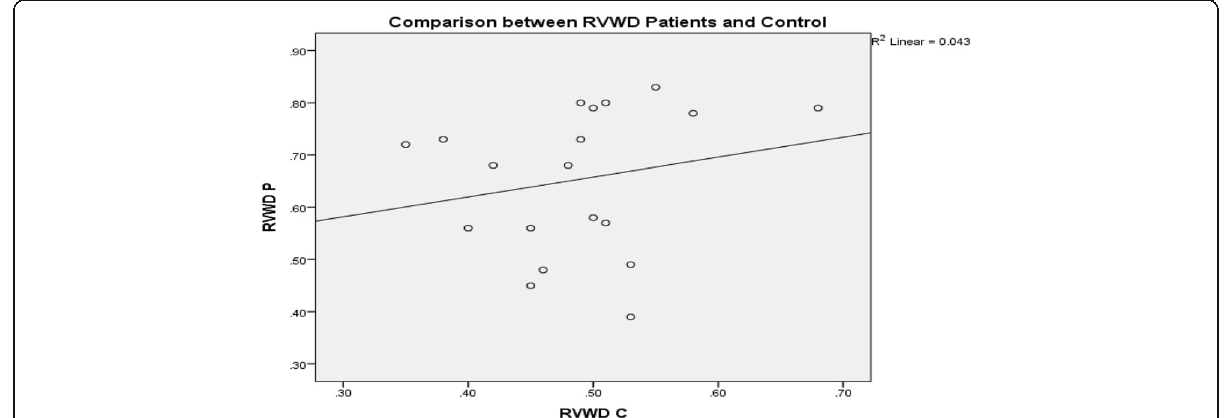
Fig. 2 Linear regression curve to illustrate significant correlation between RVWT for both patients and controls (correlation coefficient R 2 =